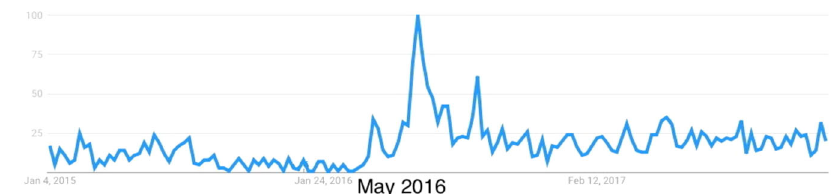
Fig. 1 Google Trend for “ Dinero Electrónico ” (Mobile Money) in Ecuador. The Google trend for searches in Ecuador that were made with the phrase “ dinero electrónico ” , or electronic money. After the OLEPF in May 2016, the search for information about electronic money was at its highest